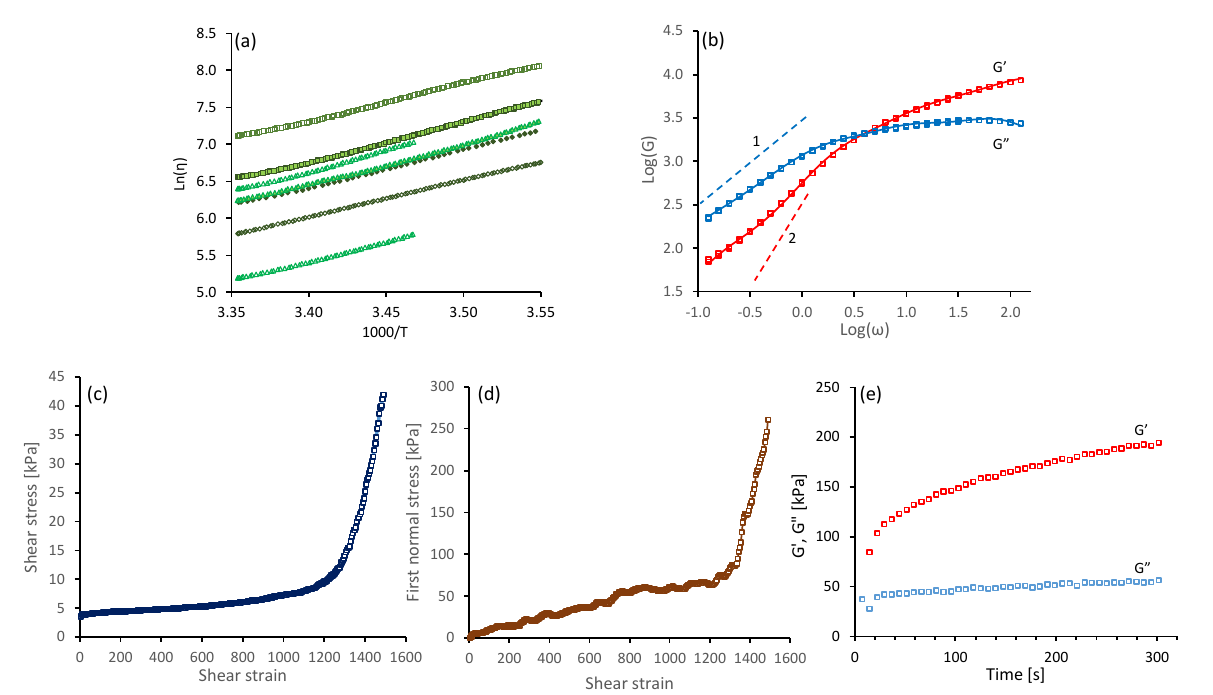
Figure 6. Rheological data measured in shear flow, for specimens of NSF used in this study. ( a ) Arrhenius plots of ln η against 1000/ T ; different symbols indicate different specimens. ( b ) Exemplar oscillatory data ( G (cid:48) and G (cid:48)(cid:48) against the angular frequency, at 15 ◦ C on double logaritmic axes. The continuous red and blue lines indicate the best fit using a Maxwellian model (see Equations (18) and (19) and Table 3). The grey dashed lines indicate the slopes of 1 and 2 expected for log G (cid:48)(cid:48) and log G (cid:48) in the ‘terminal’ frequency zone. ( c , d ) Shear stress ( σ ) and first normal stress ( N 1 ) against time at ˙ γ = 5 s − 1 and 15 ◦ C. ( e ) Changes in dynamic moduli (at 1 rad s − 1 ) after initiating gelation by flow (as shown in panels ( c ) and ( d )).